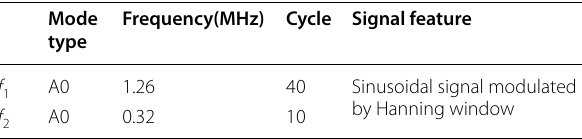
Table 5 Parameters of excitation signal